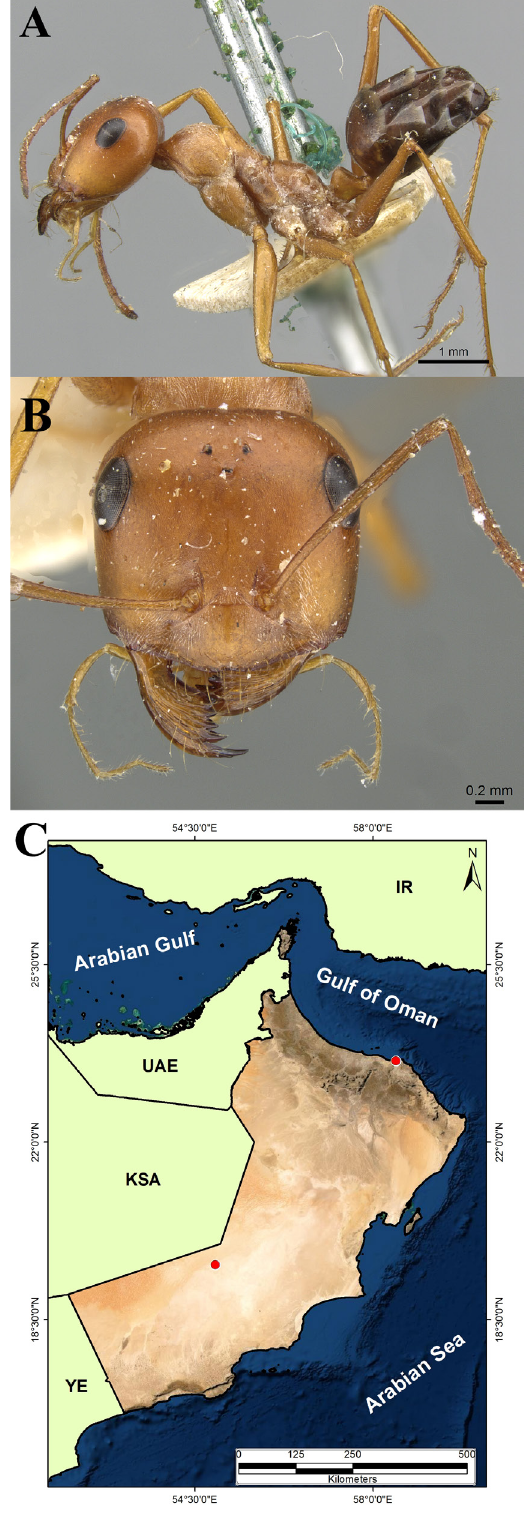
Fig. 12. Cataglyphis rubra (Forel, 1903), syntype, worker (CASENT0911102, AntWeb.org (Zach Lieberman)). A . Body in profile. B . Head in full-face view. C . Distribution